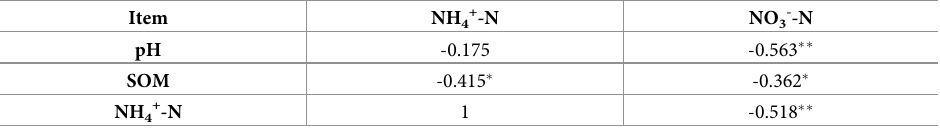
Table 4. Pearson correlation between soil pH, soil organic matter (SOM), NH4+-N and NO3—N.